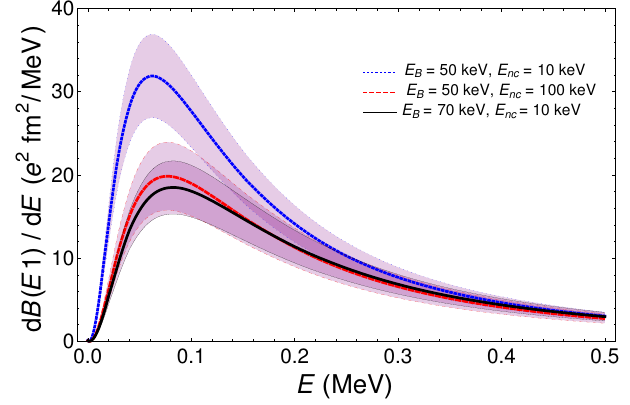
Figure 3. The dipole response spectrum for 22 C for E B = 50 keV, E nc = 10 keV (blue, dotted); E B = 50 keV, E nc = 100 keV (red, dashed) and E B = 70 keV, E nc = 10 keV (black), with their EFT error